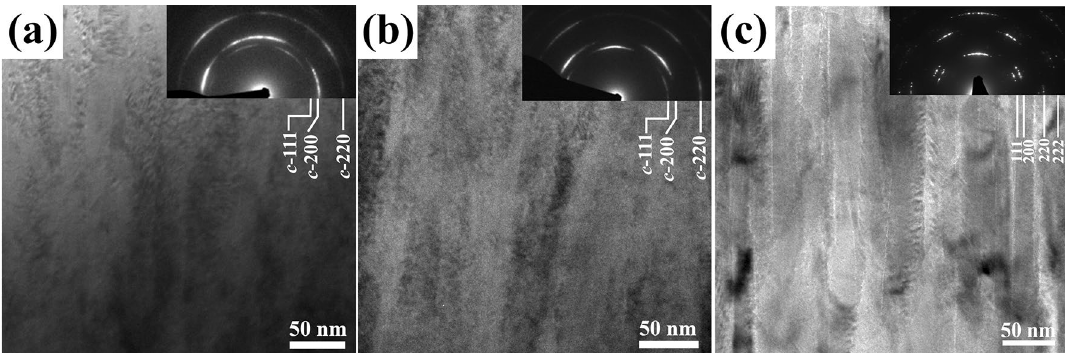
Figure 5. The bright field XTEM images with corresponding selected-area electron diffraction (SAED) patterns for ( a ) Ti 0.32 Al 0.63 W 0.05 N (50 μs, 540 V), ( b ) Ti 0.31 Al 0.60 W 0.09 N (100 μs, 240 V), and ( c ) the reference Ti 0.48 Al 0.52 N layers. The last image is adopted from Ref. 21